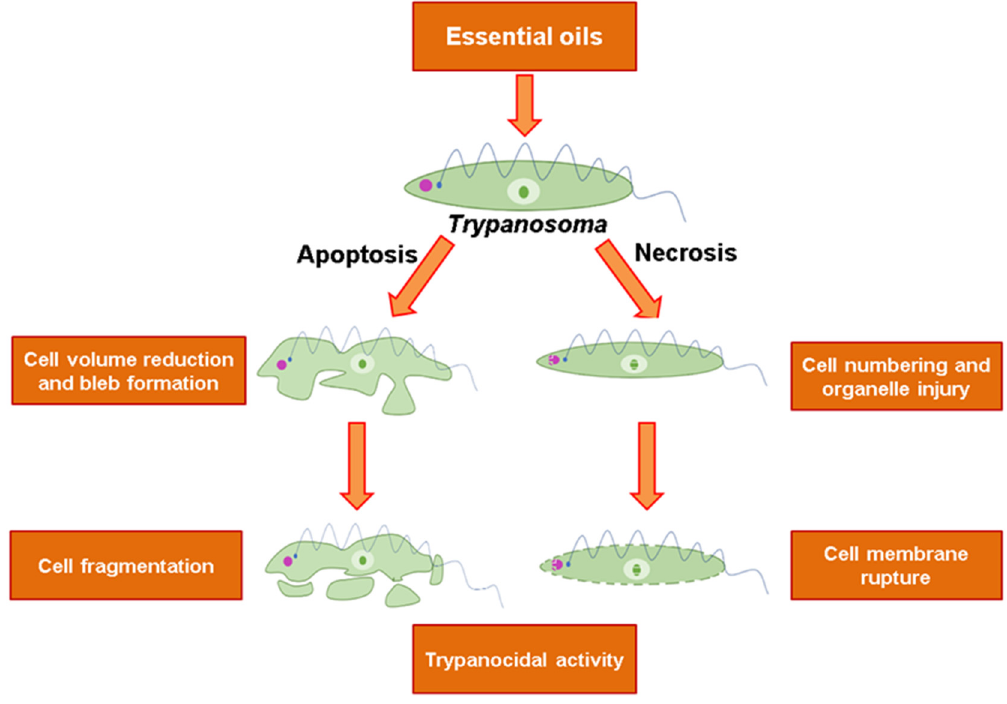
Figure 2. Main mechanisms of the trypanocidal action of essential oils. Source: Adapted from Grivicich, I.; Regner, A.; da Rocha, A.B., 2007 [72].